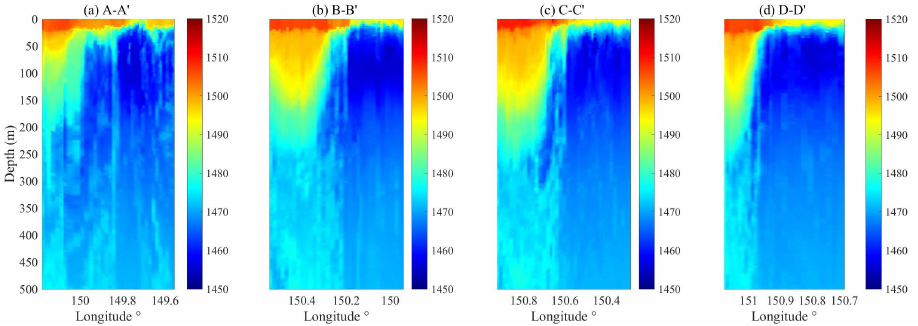
Figure 8. Measured sound speed profile from ( a – d ) is the survey line A–A (cid:48) , B–B (cid:48) , C–C (cid:48) and D–D (cid:48) , respectively, which are marked in Figure